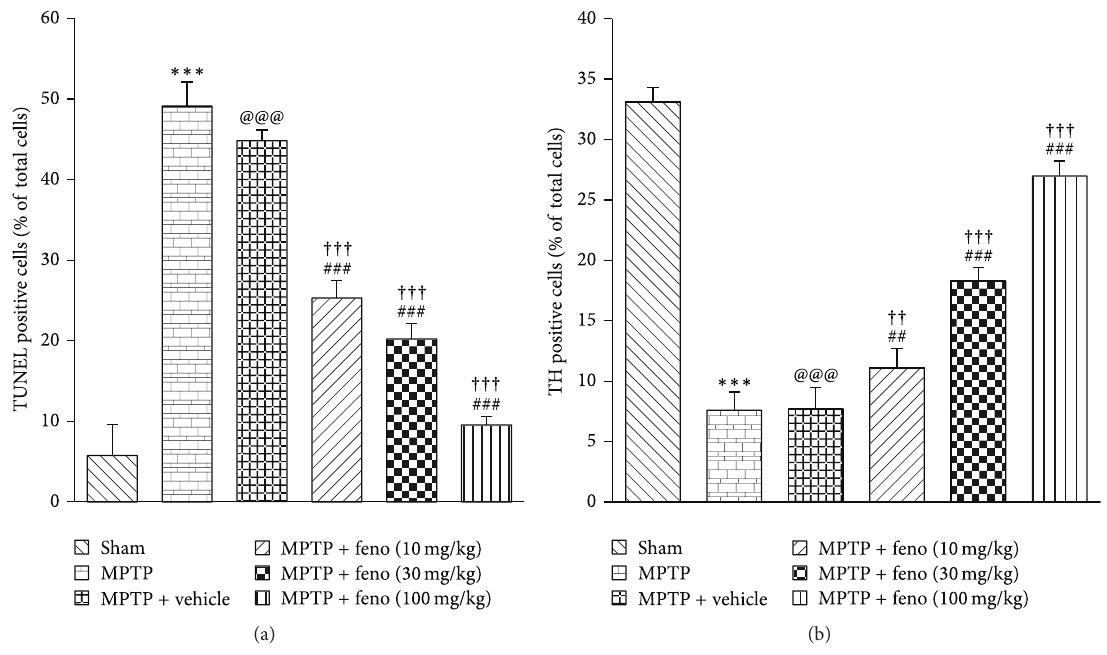
Figure 4: (a) Quantification of DNA fragmentation observed in TUNEL assay. (b) Tyrosine hydroxylase immunohistochemistry and effect of fenofibrate. ∗∗∗ 𝑃 < 0.001 MPTP versus sham, @@@ 𝑃 < 0.001 MPTP + vehicle versus sham, ## 𝑃 < 0.01 , ### 𝑃 < 0.001 MPTP versus feno 10, 30, and 100mg/kg treated groups, †† 𝑃 < 0.01 , ††† 𝑃 < 0.001 MPTP + vehicle versus feno 10, 30, and 100mg/kg group. All readings are expressed as mean ± SEM ( 𝑛 = 3 ) and images were acquired at 40X magnification.